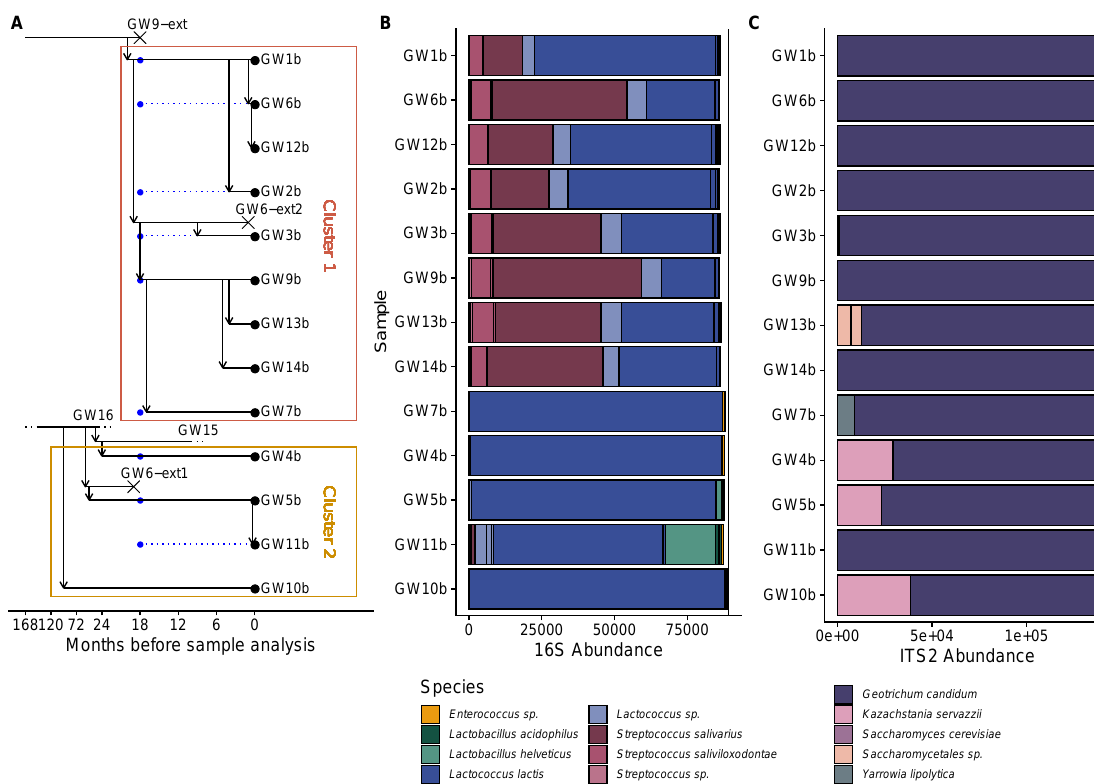
Figure 6. History of ferment exchanges and species identified in Gwell using 16S and ITS2 metabarcoding. ( A ) Gwell exchange diagram. The horizontal axis represents the time in months. The scale has a 6-month step between 0 and 24 months, and a 48-month step between 24 and 168 months. Horizontal lines represent the period of time during which each producer continuously back-slopped his Gwell. A vertical arrow pointing from producer X to producer Y represents the acquisition of a ferment by producer Y from producer X.. Samples that were analyzed during this study are symbolized by a point. Blue points represent Gwell that were analyzed using culture-dependent methods and black points represent samples that were analyzed with culture-independent methods. Gwell that became extinct are marked with a cross and labeled “ext” after the producer’s name. ( B , C ) Abundance of species identified by 16S V3V4 and ITS2 regions, respectively. All Operational Taxonomic Units (OTUs) whose abundance was lower than 0.5% of total sample abundance were discarded, and only the five most abundant species are shown. Species are differentiated by color and black lines inside the bars delimit different OTU. The vertical line represents the total rarefied sample